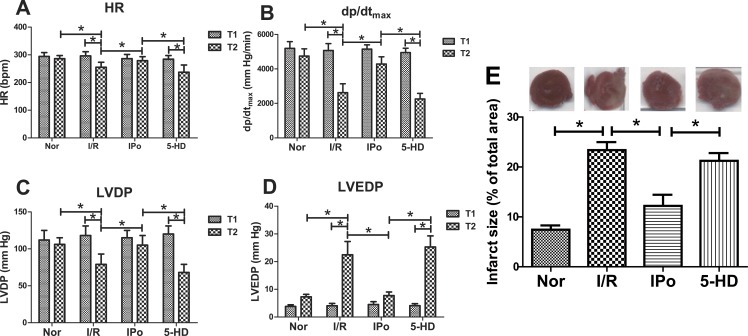
Comparison of hemodynamic parameters and infarct size.IPo effectively reduced myocardial dysfunction (A–D) and infarct size (E) induced by MIRI while 5-HD partially conteracted IPo’s effects on hemodynamic parameters and infarct size. n = 6 (A–D) or 4 (E) in each group. ∗P < 0.05.